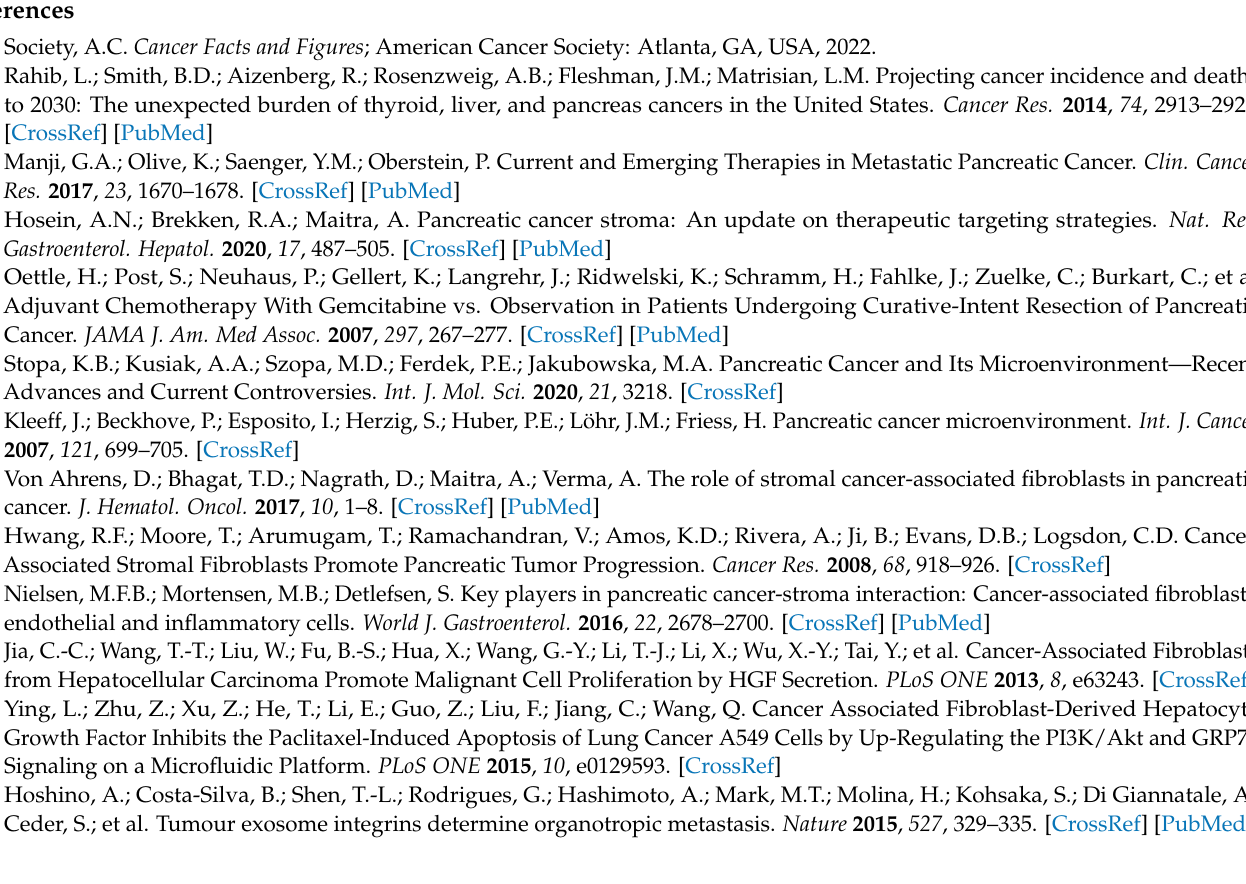
Table S1: Cellular pathways and genetic targets of identified microRNAs; Figure S2: Western blot analysis of PTEN/p-AKT expression in cells where exosomes are retained or depleted from CAF- derived